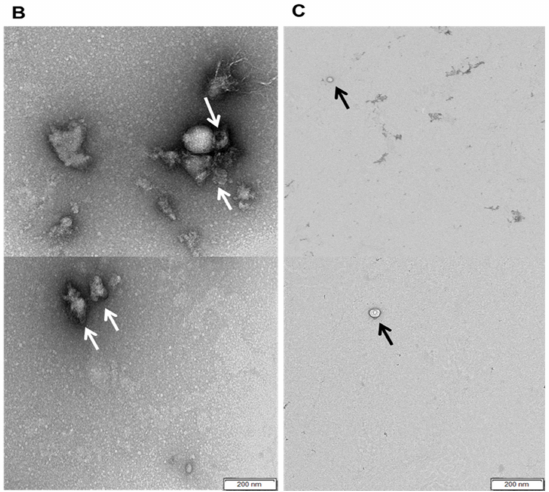
Figure 5. Nanoparticle tracking analysis and transmission electron microscopy were applied to assess the concentration, size and morphology of nanoparticles in blank BSA embryo culture medium (SOF+ITS+BSA) ( A ) before and after OptiPrep™ density gradient ultracentrifugation (ODG UC) (EVs isolation procedure). For the nanoparticle tracking analysis, ODG UC processed embryo conditioned medium (fraction 8–9) was included as a comparison. Similarly, transmission electron microscopy images before ( B ) and after (C) ODG UC (EVs isolation procedure) are shown. The concentration of particles in blank BSA medium before EVs isolation procedure was 66.5 × 10 9 particles/mL while after EVs isolation procedure the concentration was 53.7 × 10 8 particles/mL. The nanoparticle size range before EV isolation procedure was between 70 and 400 nm and after EVs isolation procedure between 70 and 250 nm. Images demonstrate (B) EV-like structures (indicated with white arrows) in blank BSA medium before EV isolation. ( C ) After EVs isolation procedure, blank BSA medium did not show EV-like structures anymore but only some lipoproteins (black